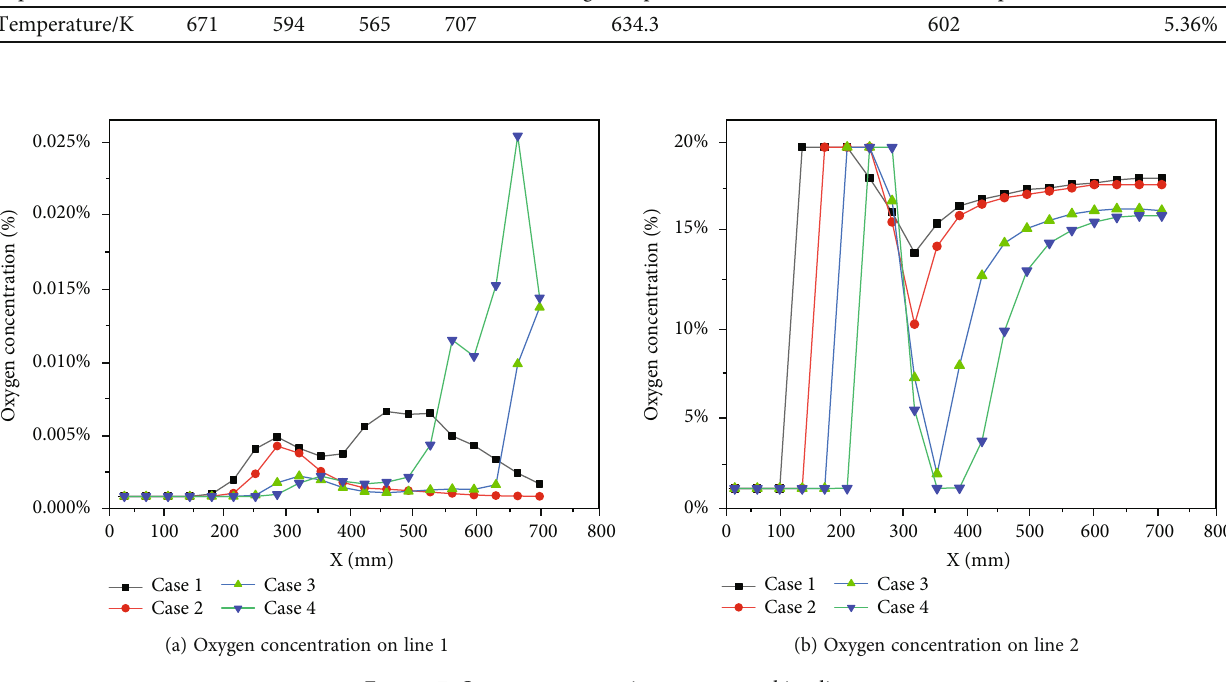
Figure 7: Oxygen concentration on two marking lines.